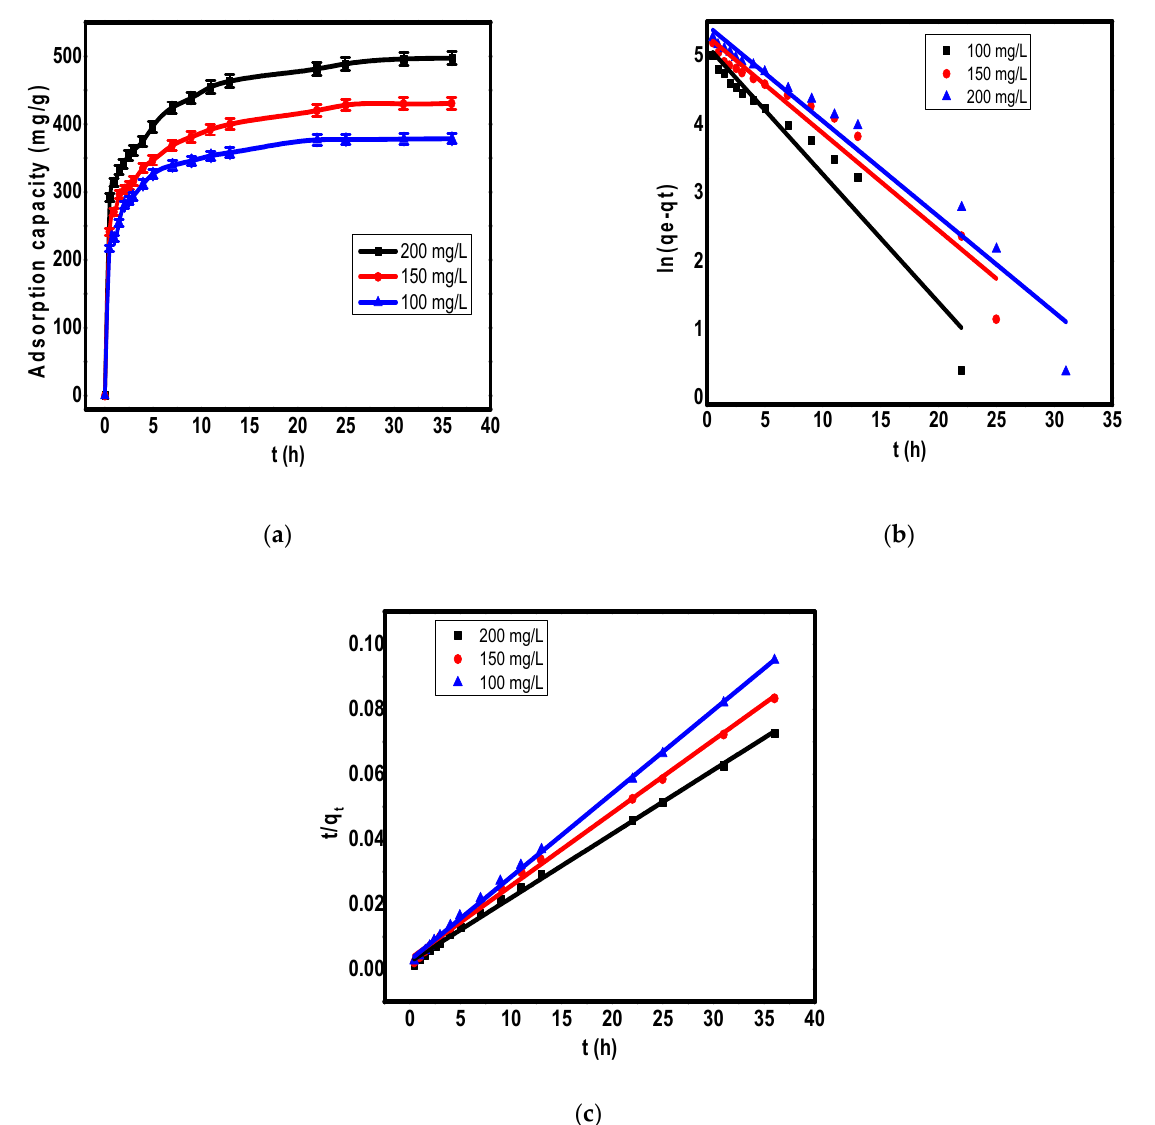
Figure 5. The effect of contact time at different initial Cr(VI) concentrations ( a ), fit of experimental data to pseudo 1st order model ( b ), and fit of experimental data to pseudo 2nd order model ( c ) for the removal of Cr(VI) ions on the surface of ppy/NC nanocomposite